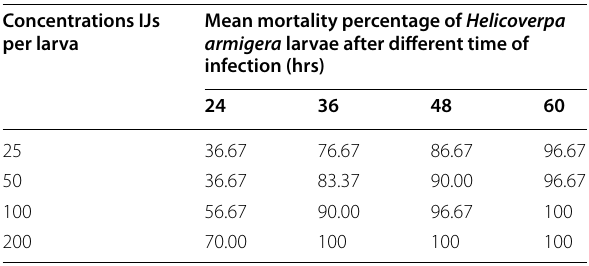
Table 3 Mean mortality percentages of Helicoverpa armigera larvae infected with isolate Steinernema abbasi (IJs) CS39 at different concentrations Concentrations IJs per larva